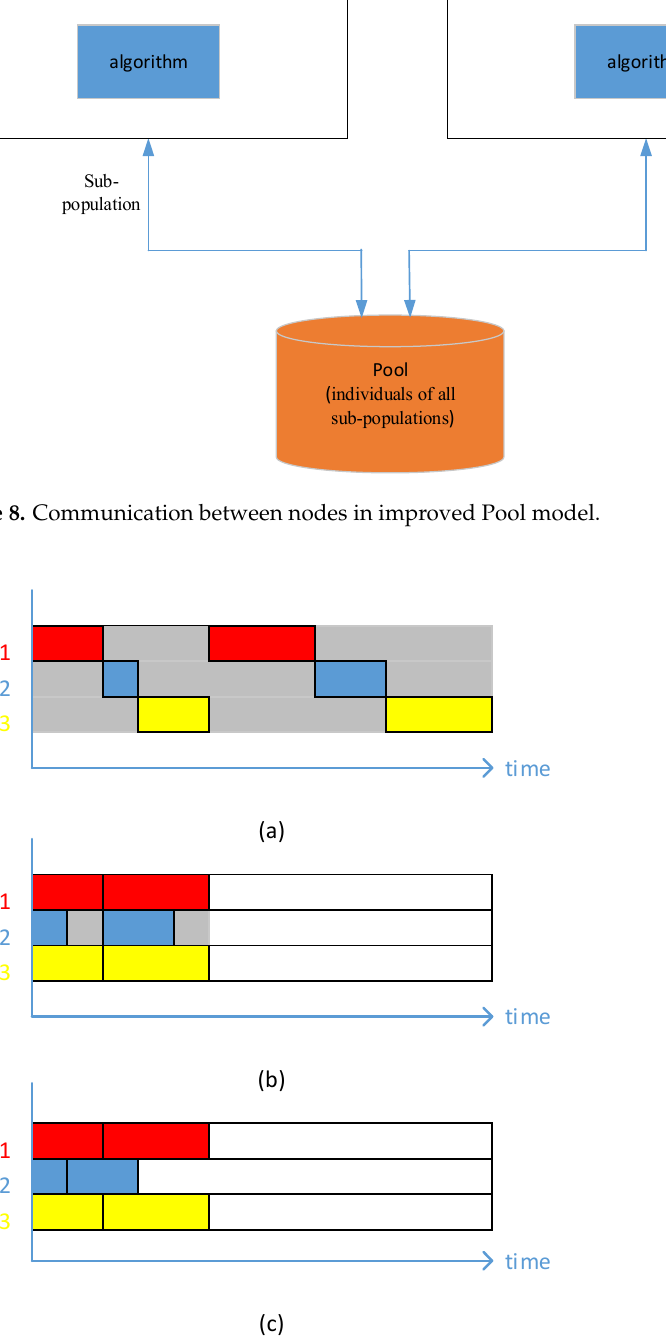
Figure 9. Parallel propulsion modes: ( a ) synchronous sequential propulsion; ( b ) synchronous parallel propulsion; ( c ) asynchronous parallel propulsion.